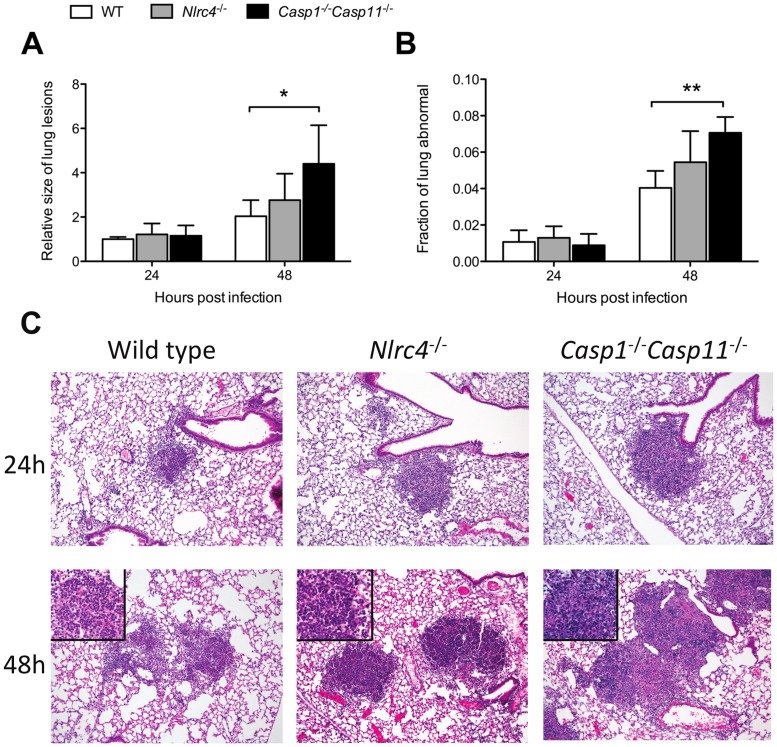

Nlrc4- and Caspase-1/Caspase-11-dependent histologic changes in the lung during respiratory melioidosis.Wild type (WT), Nlrc4
−/−, and Casp1
−/−
Casp11
−/− mice were infected with 314 CFU/lung or 194 CFU/lung aerosolized B. pseudomallei 1026b in two separate experiments. Lungs were fixed and stained with hematoxylin and eosin 24 and 48 hours after infection. The average size of each focal pulmonary infiltrate normalized to measures from wild type mice at 24 hours (A) and the fraction of total lung area that was abnormal (B) were quantified for each group of mice. Data displayed are means ± SD from the two experiments. N = 4–7 per group per timepoint. *, p≤0.05, **, p≤0.01. (C) Representative histologic features of pulmonary infection with B. pseudomallei. At 24 h post-infection lesions are similar between the groups in pattern, distribution and size but have slightly varying morphologic features. Inflammatory foci in WT mice are composed of moderately dense aggregates of nearly pure, intact neutrophils that fill vessels and alveolar spaces but preserve architectural elements. In contrast focal inflammatory cell aggregates in Nlrc4
−/− and Casp1
−/−
Casp11
−/− while also predominately neutrophilic (with few mononuclear cells) are much more densely packed, slightly obscuring some normal structures and, in the case of Casp1
−/−
Casp11
−/− showing early evidence of nuclear fragmentation. By 48 hours post-infection phenotypic differences are more distinct. Focal lesions within WT mice while modestly larger remain predominately neutrophilic with limited evidence of parenchymal tissue necrosis and relatively mild neutrophil condensation and fragmentation. Nuclear condensation and fragmentation is a hallmark of lesions in Nlrc4
−/− mice at 48 h but parenchymal injury remains relatively modest with many alveolar wall outlines preserved and small airway involvement very limited. Mixed inflammatory cells surround these lesions. This contrasts with the severe injury evident in Casp1
−/−
Casp11
−/− mice at 48 h. In these mice lesions are substantially larger and efface all or most parenchymal and vascular structures which are focally replaced by necrotic cells and a dark pink coagulum containing variably fine nuclear debris. This debris commonly extends into small airways. Intact inflammatory cells of any type are rarely evident within these lesions although adjacent vessels are surrounded by small numbers of intact mononuclear cells.